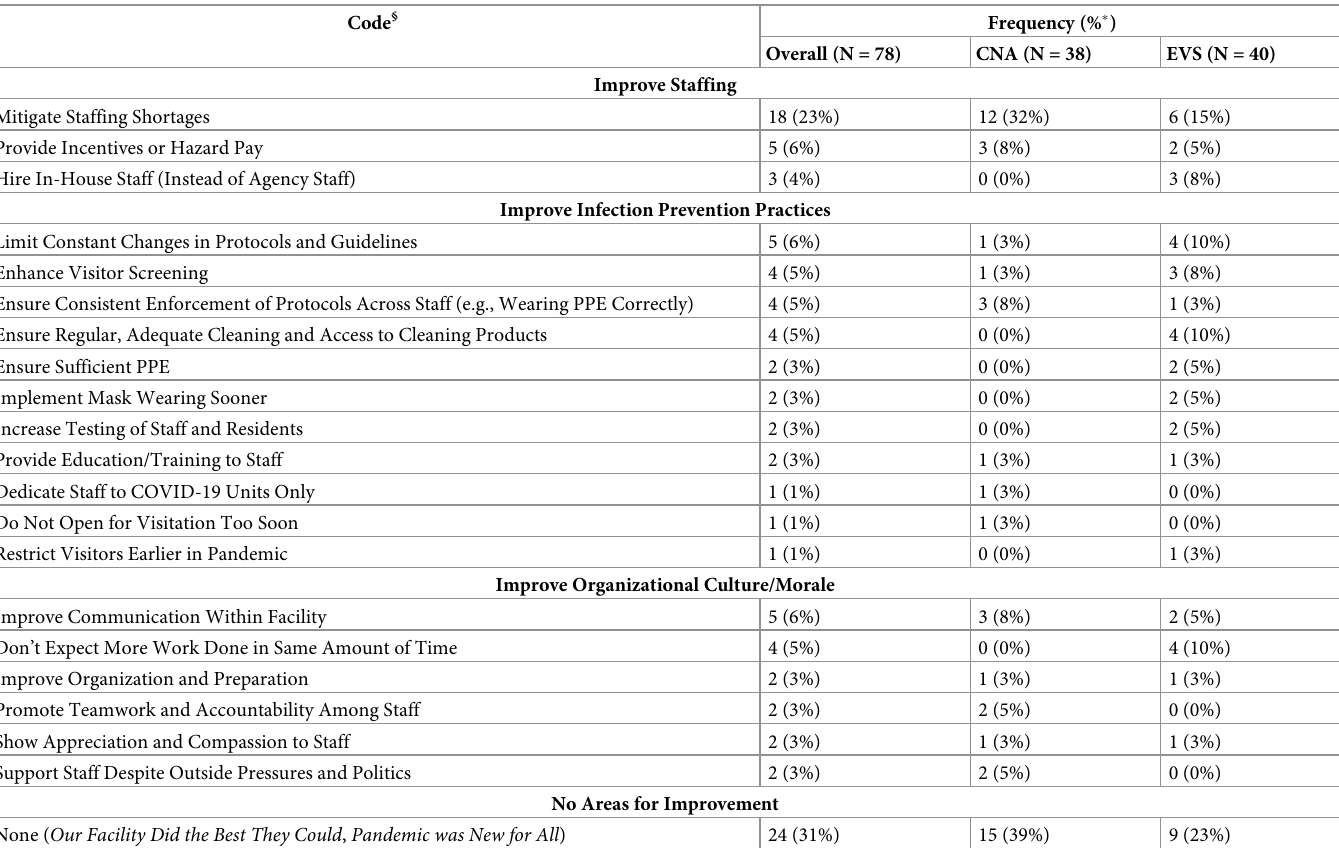
Table 4. Frequency of qualitative codes by theme: What can your nursing home improve